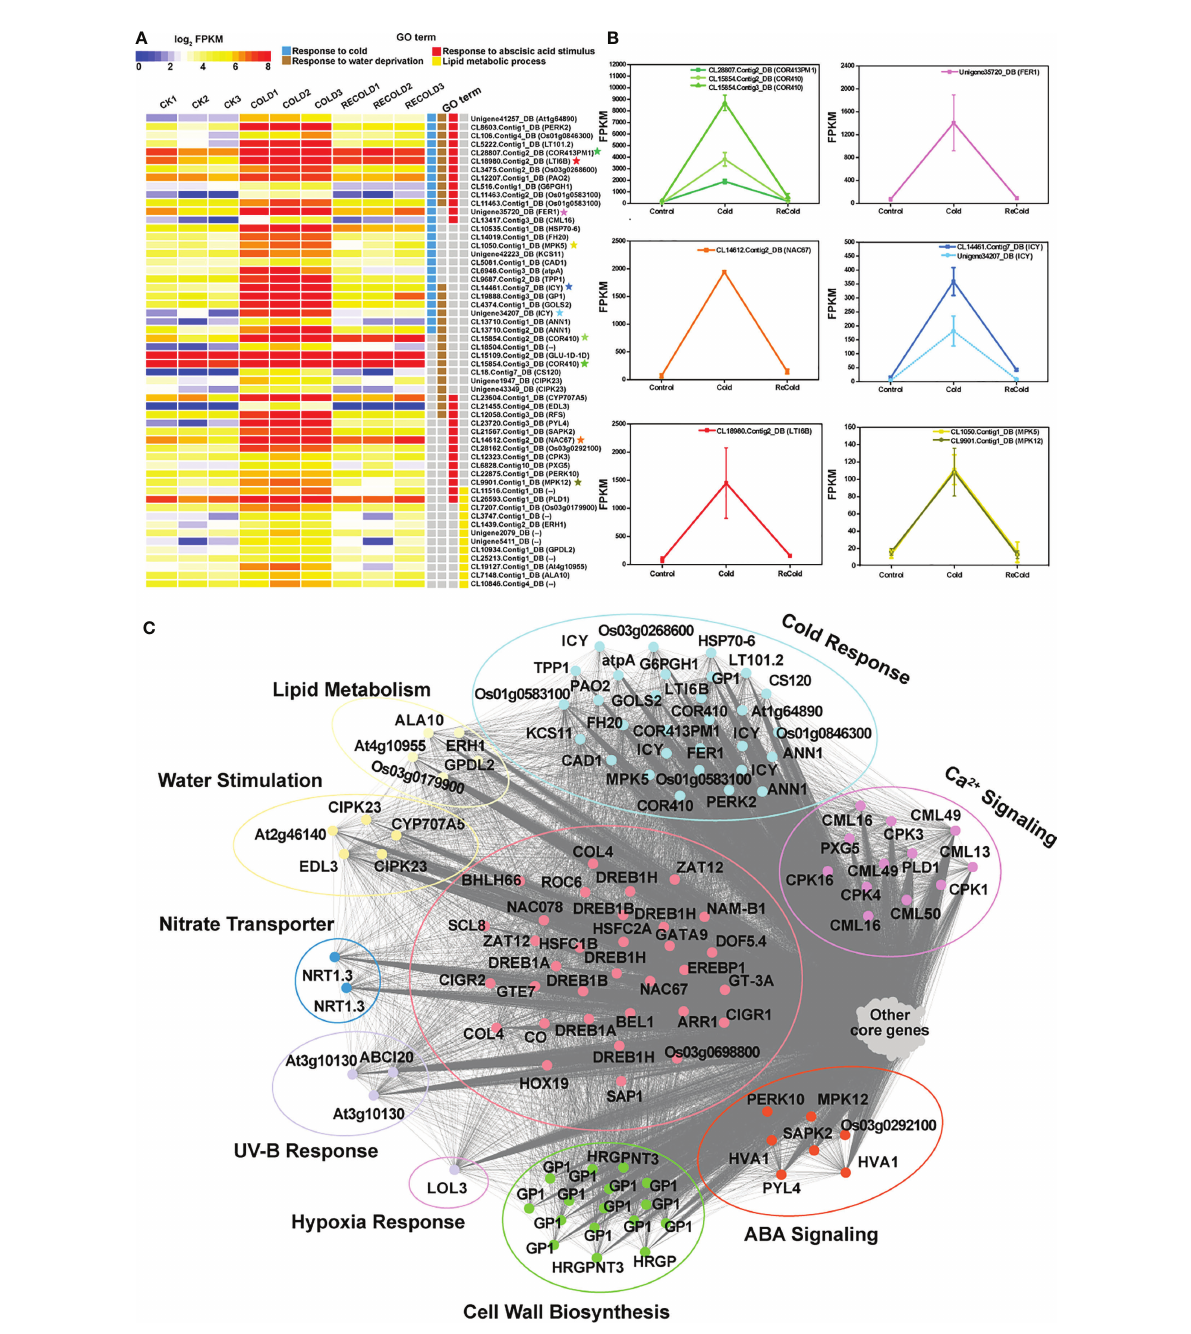
FIGURE 8 The expression patterns and functions of CMEblue core genes under cold. (A) Expression pro fi les of the representative CMEblue genes (Supplementary Figure S3). In the heat map, each gene has three stages and three repetitions. Color intensity represents the expression level, and different GO terms are represented by four columns with different colors. Some genes marked with stars as the characterization of GO term show expression trends in line graphs. (B) The line graphs of some function genes with a star mark related to the cold stress response. The horizontal axis denotes the sampling points, and the vertical coordinate re fl ects the gene expression level (FPKM value). (C) Different functions of CMEblue hub genes. The edges represent potential relationships between genes, and the thicker the line, the stronger the